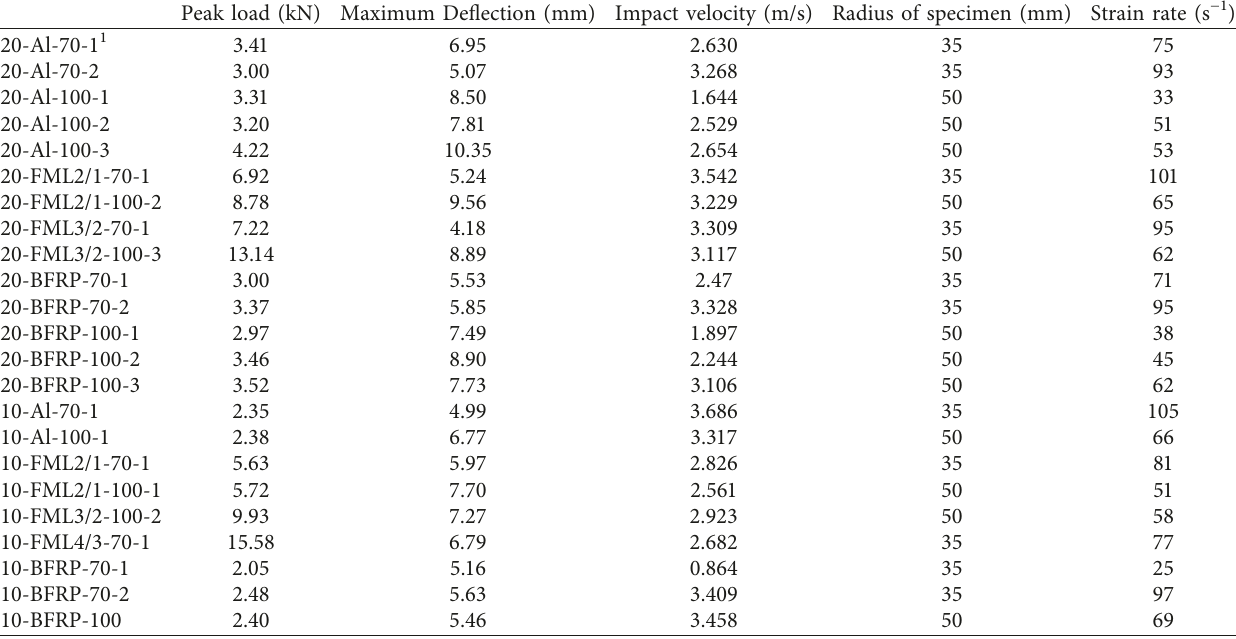
Table 6: Test results of the drop-weight impact.